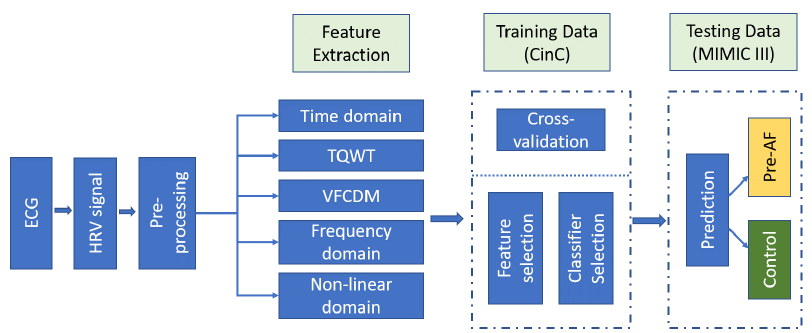
Figure 8. Overview of the proposed AF prediction